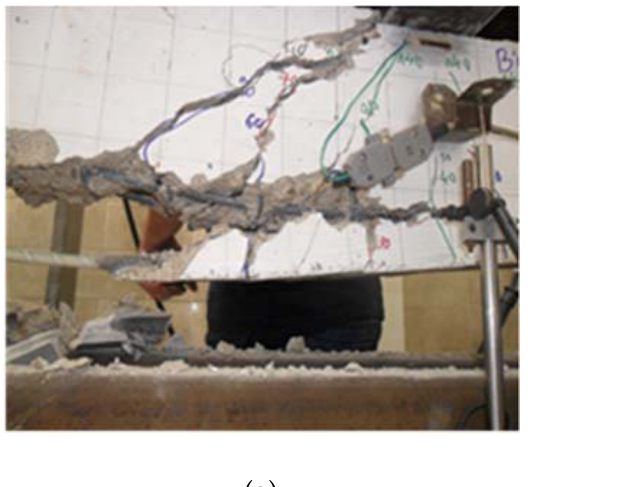
Figure 18. Beam B-G2: ( a ) Failure of the cross section above the support; ( b ) Failure of cross section in the span due to concrete separation.